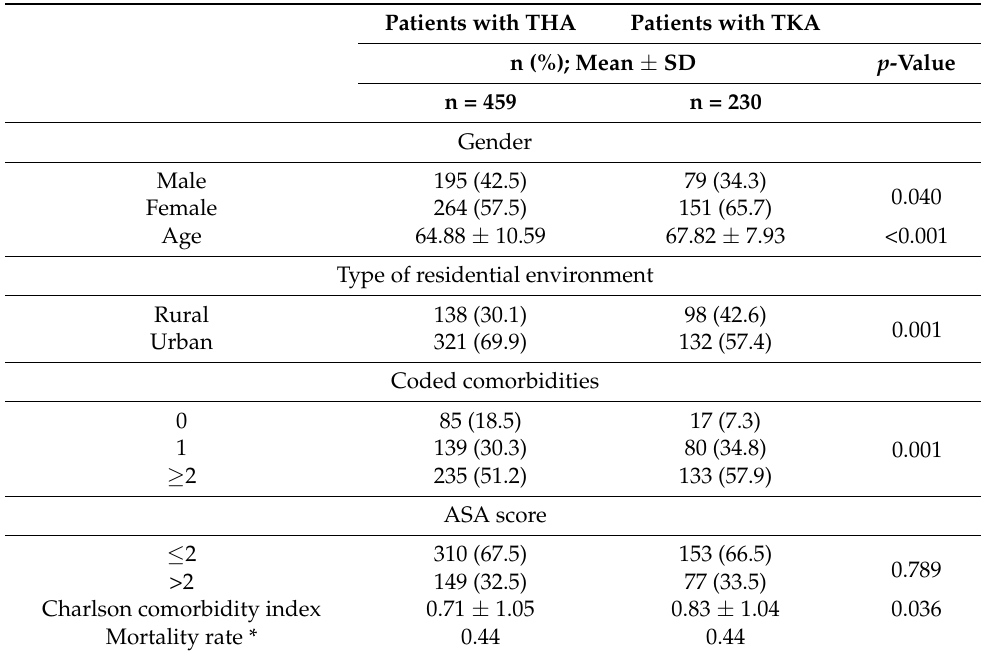
Table 1. Baseline patient characteristics with THA and